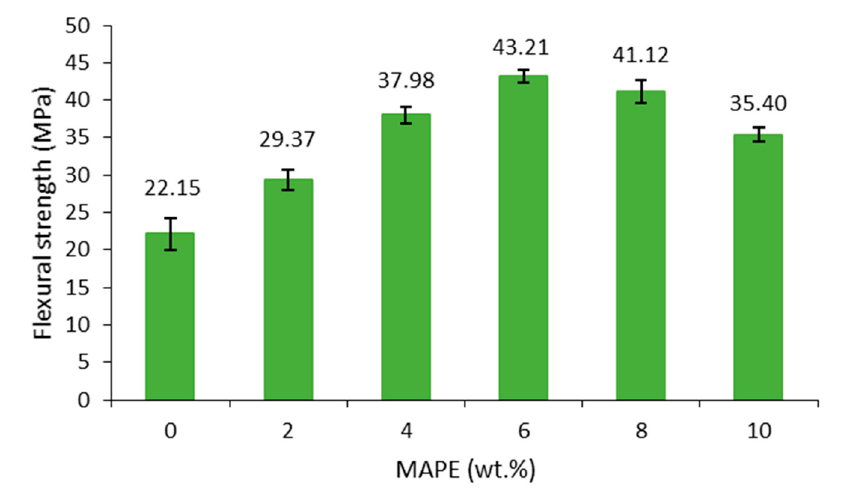
Figure 4. Flexural strength of composites at 30 wt.% and different MAPE content.